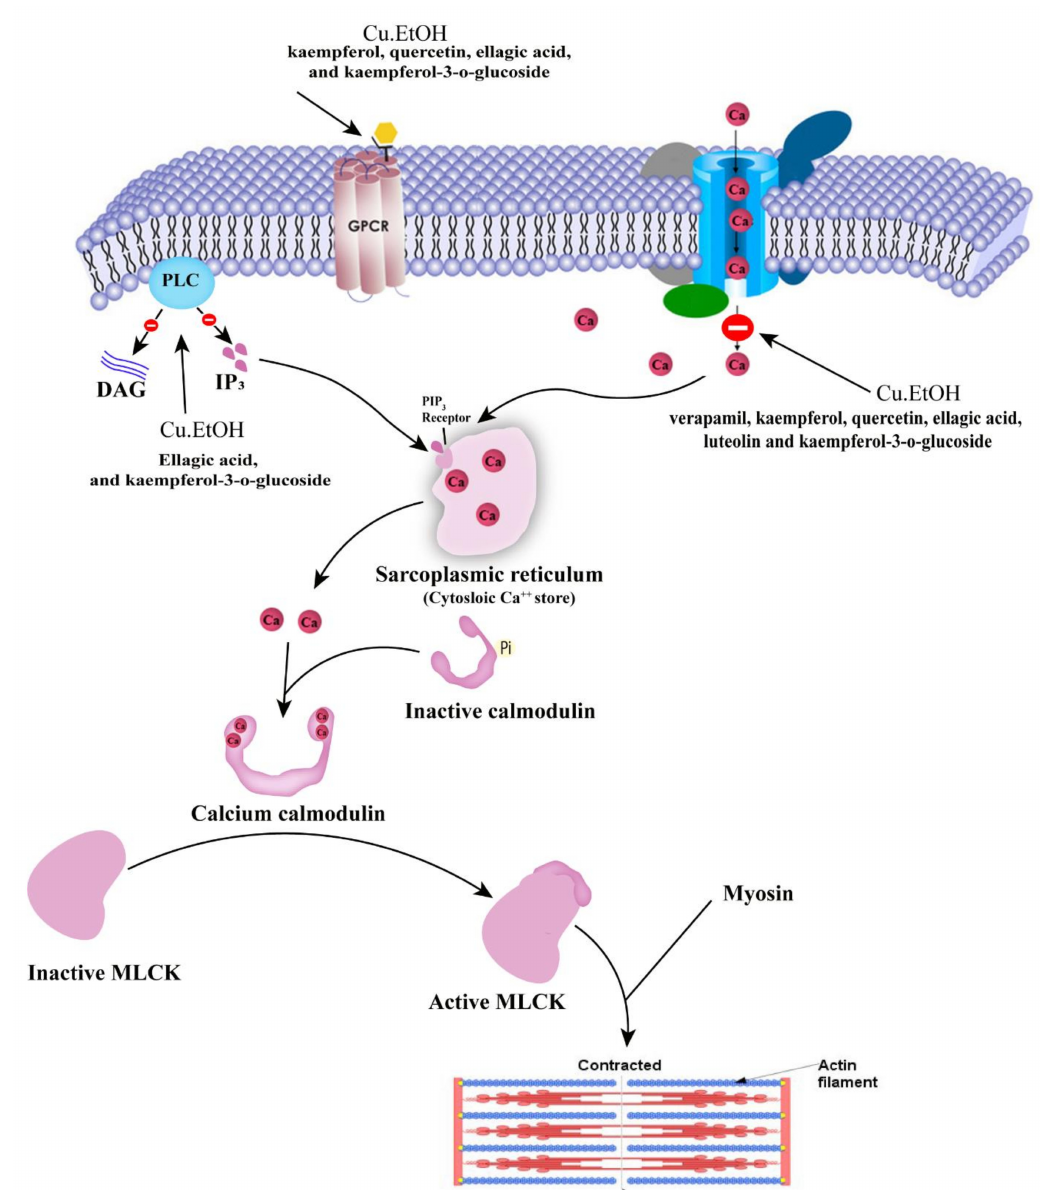
Figure 12. Schematic diagram of proposed mechanism of C. sativus seeds extracts on L type voltage gated calcium ion channel, M 3 muscarinic receptor and phosphoinositide phospholipase C (PLC). (IP3: inositol 1, 4, 5-trisphosphate, DAG: Diacylglycerol MLCK: Myosin Light Chain